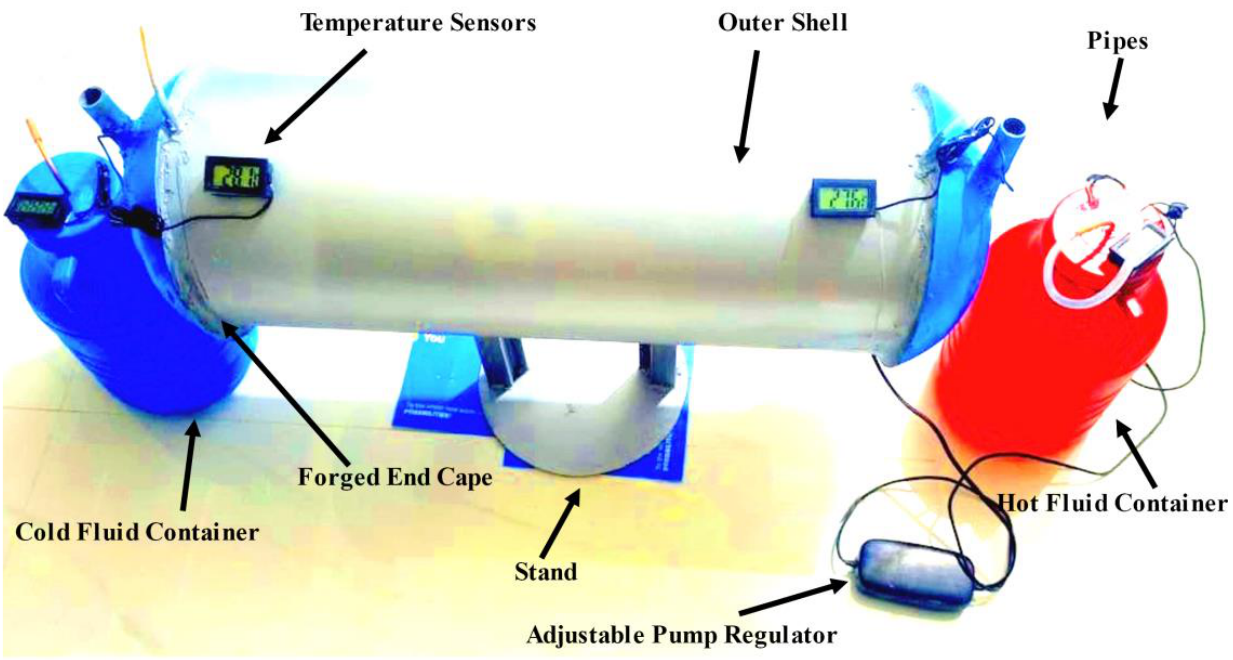
Figure 4. Schematic diagram of the fabricated model of the heat exchanger.